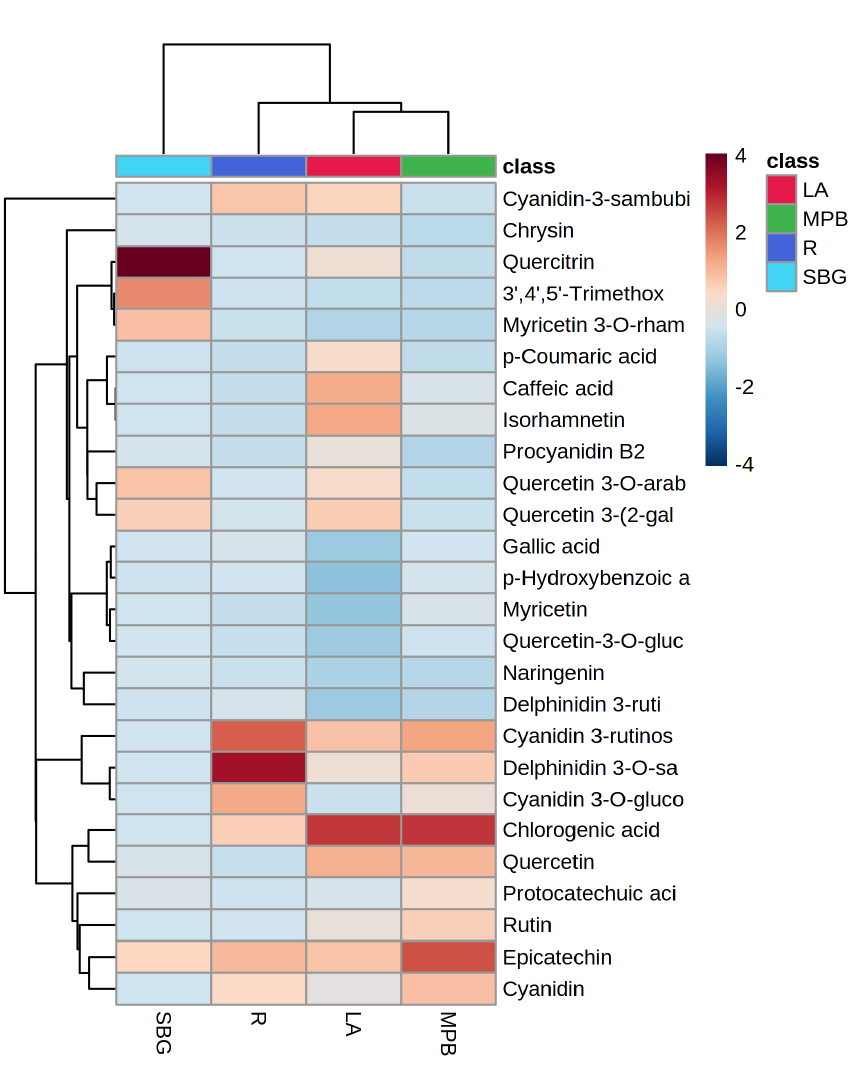
Figure 3. Heatmap hierarchical clustering of quantified phenolic compounds in mountain pepper berries ( MPB ), lemon aspen ( LS ), rosella ( R ), and strawberry gum ( SBG